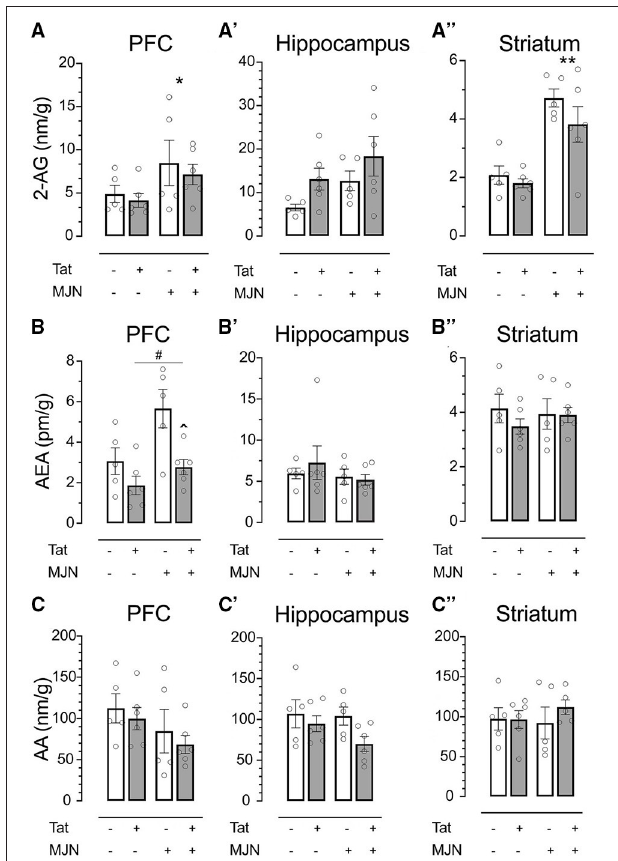
FIGURE 5 | (A) MJN110 treatment significantly increased PFC 2-AG levels across genotypes. (A’) Neither Tat nor MJN110 significantly affected hippocampal 2-AG levels. (A”) MJN110 significantly increased striatal 2-AG levels across genotypes. (B) Tat( + ) subjects across treatment groups had significantly lower PFC AEA levels relative to Tat(–) controls. MJN110 significantly increased PFC AEA in Tat( + ) subjects. No significant differences in hippocampal (B’) or striatal AEA (B”) were observed between groups. No significant differences in PFC (C) , hippocampal (C’) , or striatal AA (C”) were observed between groups. Data are mean ± SEM. Statistical significance was determined using ANOVA and Bonferroni correction where applicable. An alpha level of p < 0.05 was considered significant for all statistical tests. * p < 0.05 vs. vehicle treatment; ** p < 0.0001 vs. vehicle treatment; ∧ p < 0.05 vs. vehicle-treated Tat( + ) subjects; # p < 0.01 vs. Tat( − )